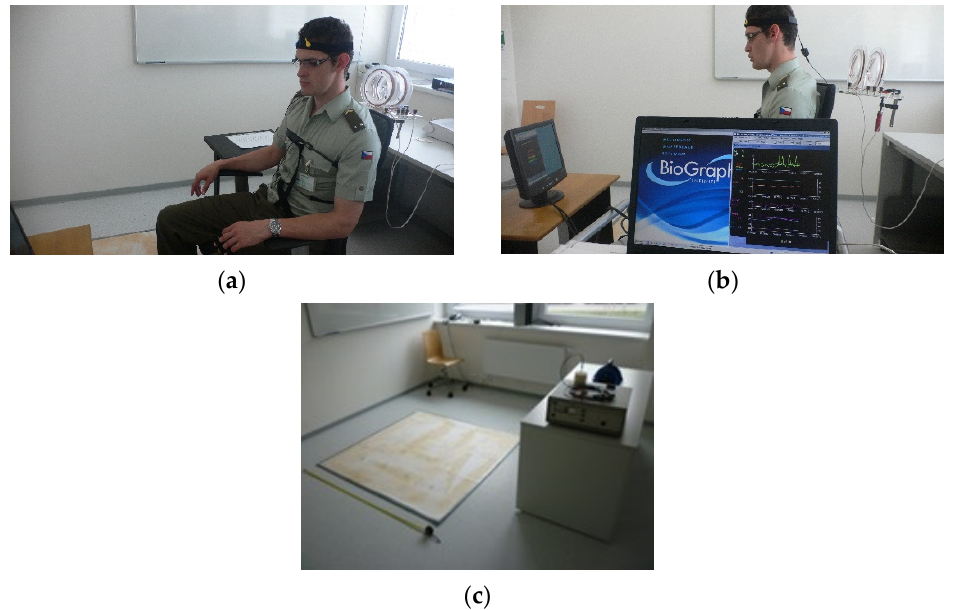
Figure 3. ( a – c ) Images of the laboratory measurements, ( a , b ); the room with a geomagnetically stable magnetic field component, ( c ).